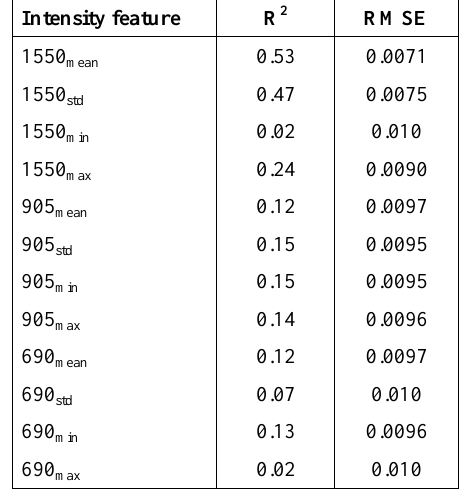
Table 1. Coefficients of determination (R 2 ) and root mean square error values (RMSE) for the regression models between single wavelength laser intensity features and equivalent water thickness.